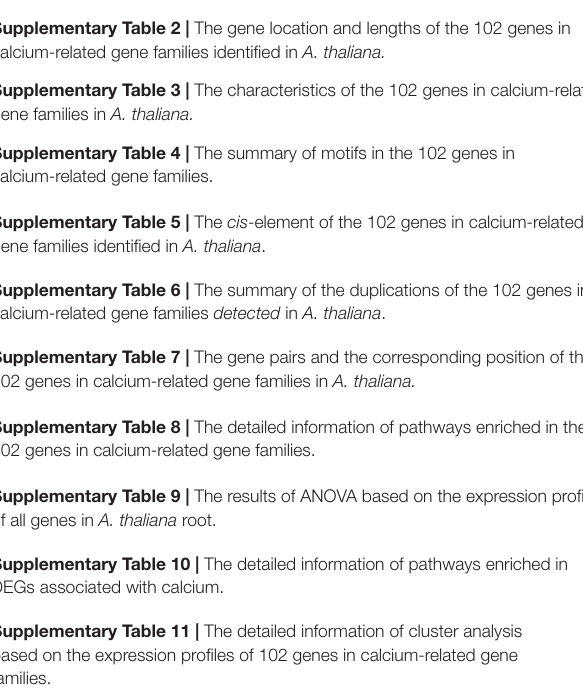
Supplementary Table 1 | The detailed information of the cutoff used in the identification of 102 genes in calcium-related gene families. Supplementary Table 2 | The gene location and lengths of the 102 genes in calcium-related gene families identified in A. thaliana. Supplementary Table 3 | The characteristics of the 102 genes in calcium-related gene families in A. thaliana. Supplementary Table 4 | The summary of motifs in the 102 genes in calcium-related gene families.